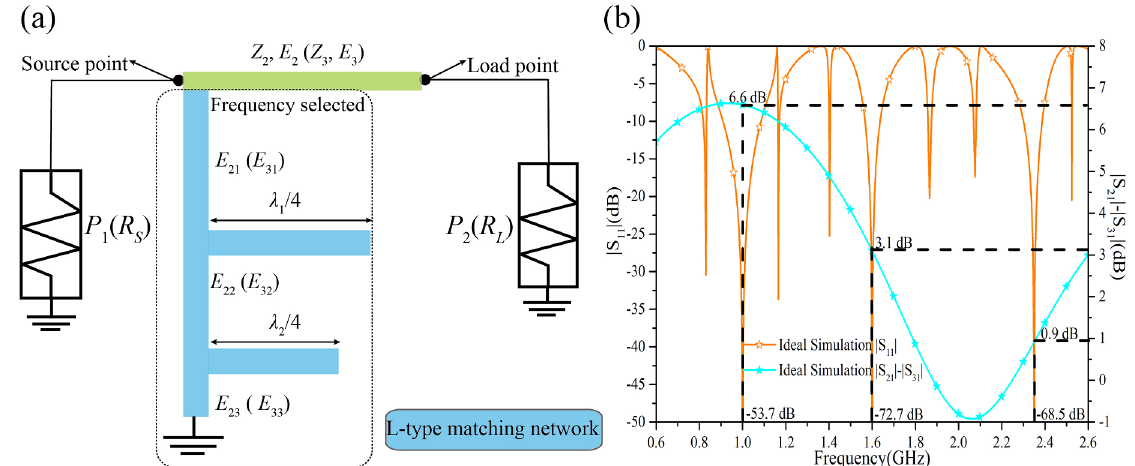
Fig 3. The layout of the proposed LN and the ideal simulation results of the TTPD. (a) The LN is made up of six transmission lines with its ideal electricalparameters. In output path-2: Z 2 = 69.83 Ω , E 2 = 28.7 @ 1 GHz, E 21 = 103.2 @ 1 GHz, E 22 = 141.4 @ 1.6 GHz, E 23 = 178.5 @ 2.35 GHz. In output path-3: Z 3 = 138.2 Ω , E 3 = 88.07 @ 1 GHz, E 31 = 90.3 @ 1 GHz, E 32 = 138.4 @ 1.6 GHz, E 33 = 41.8 @ 2.35 GHz. The input terminal impedance R 1 = 50 Ω and the output terminal impedances R 2 = 50 Ω , R 3 = 68.6 Ω . λ 1 and λ 2 are the wavelengths of 1 GHz and 1.6 GHz. (b) The simulationresults of the TTPD with the ideal electrical parameters in (a).